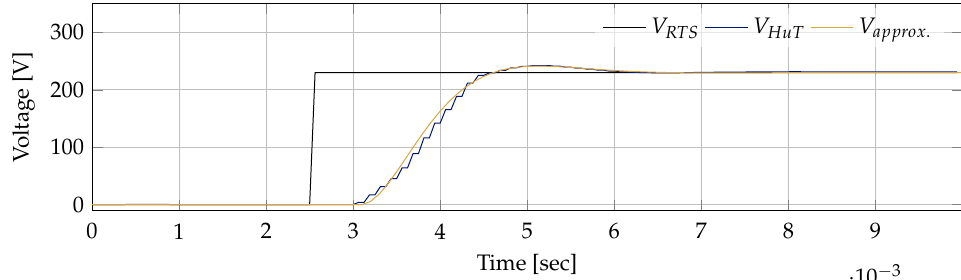
Figure 18. Step response of the switching inverter in comparison to the approximation.